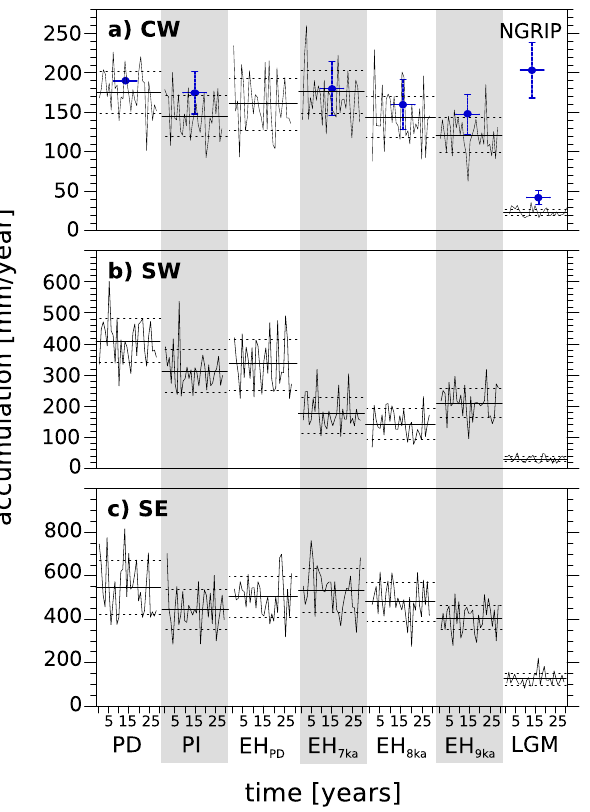
Fig. 11. Annual mean accumulation [mmyr − 1 ] records for the (a) CW, (b) SW, and (c) SE Greenland region based on the dif- ferent model simulations. The solid reference lines denote the 30yr time-slice mean accumulation, whereas the stippled lines denote ± 1 standard deviation values. Note that due to the time-slice setup, the records are not continuous. In (a) , the blue dots with error bars in- dicate the NGRIP accumulation rates determined for present day, the preindustrial era, and 7, 8, 9, and 21ka. The present NGRIP accumulation rate of 190myr − 1 has been determined by NGRIP members